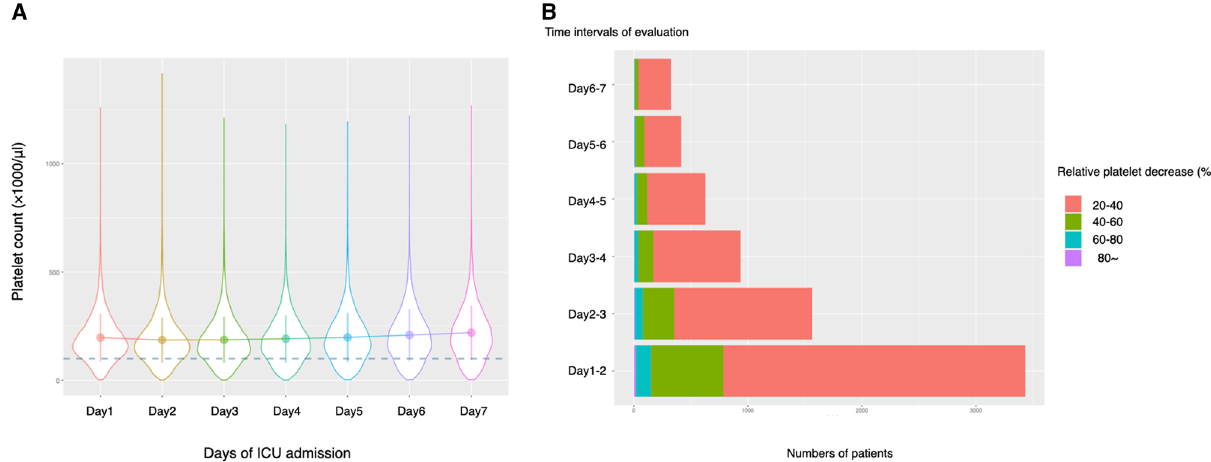
Figure 2. The trends and distribution of the platelet counts and the relative platelet reductions after the first seven days of ICU admission. ( A ) Trends and distribution of the platelet count. ( B ) Relative platelet reduction after the first seven days of ICU